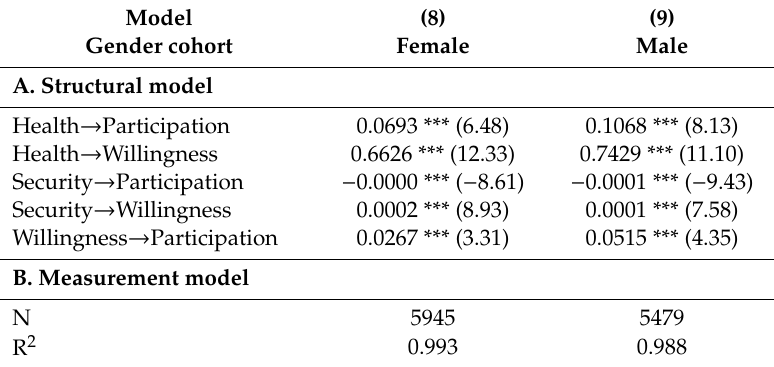
Table 6. Multi-group comparison by gender (N =